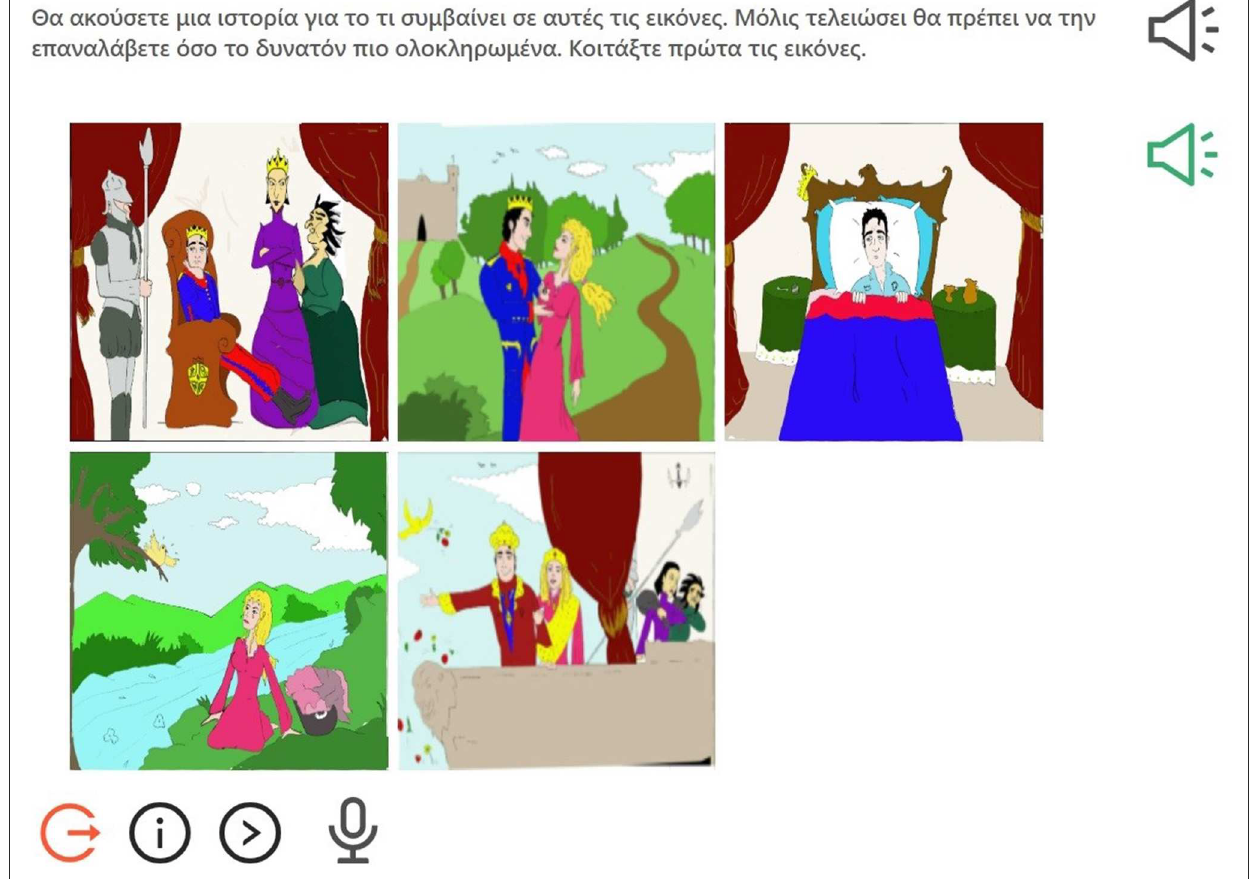
FIGURE3 Screen of the Ring task, with audio and visual stimuli (picture adopted from the Kakavoulia et al., 2014